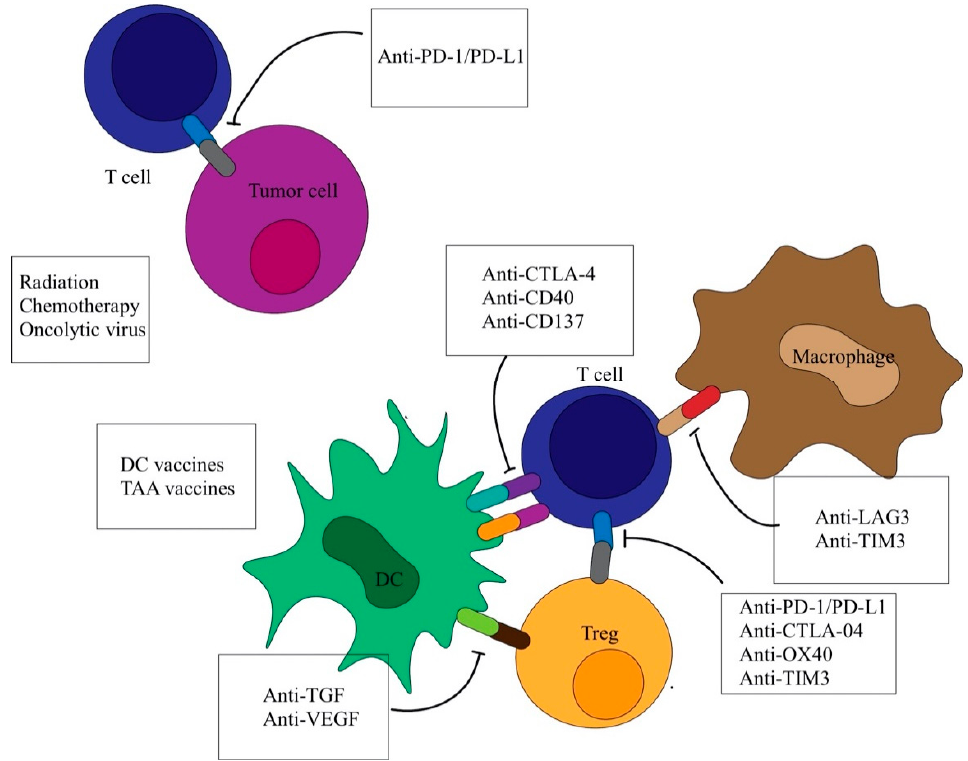
Figure 1. Immunotherapeutic mechanisms. Immune therapy targets the interface of intercellular interaction among immune cells and between immune cells and tumor cells. Such treatment modalities inhibit well-known immunological checkpoints such as the PD-1/PD-L1 and B7/CTLA-4 axes to stimulate anti-tumor immune responses. Other immune therapeutic modalities engage the antigen presentation mechanism in order to achieve the same end, for example, by cancer vaccination. Still other treatment modalities, including oncolytic therapy, target the direct destruction of tumor cells. Abbreviations: CTLA-4, cytotoxic-T lymphocyte antigen-4; PD-1/PD-L1, programmed death-1/programmed death ligand-1; LAG-3, lymphocyte activation